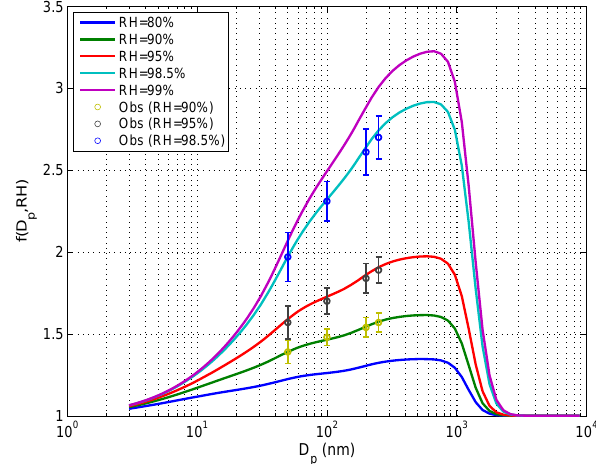
Fig. 1. Size-resolved hygroscopic growth factors at 80%, 90%, 95%, 98.5% and 99% RH (displayed in colored lines). Colored circles represent the corresponding mean values of measured hy- groscopic growth factors of particles (with dry diameters of 50nm, 100nm, 200nm and 250nm) at set RHs (90%, 95% and 98.5%, respectively) during HaChi summer campaign; the error bars repre- sent ± 1 standard deviation (Liu et al.,